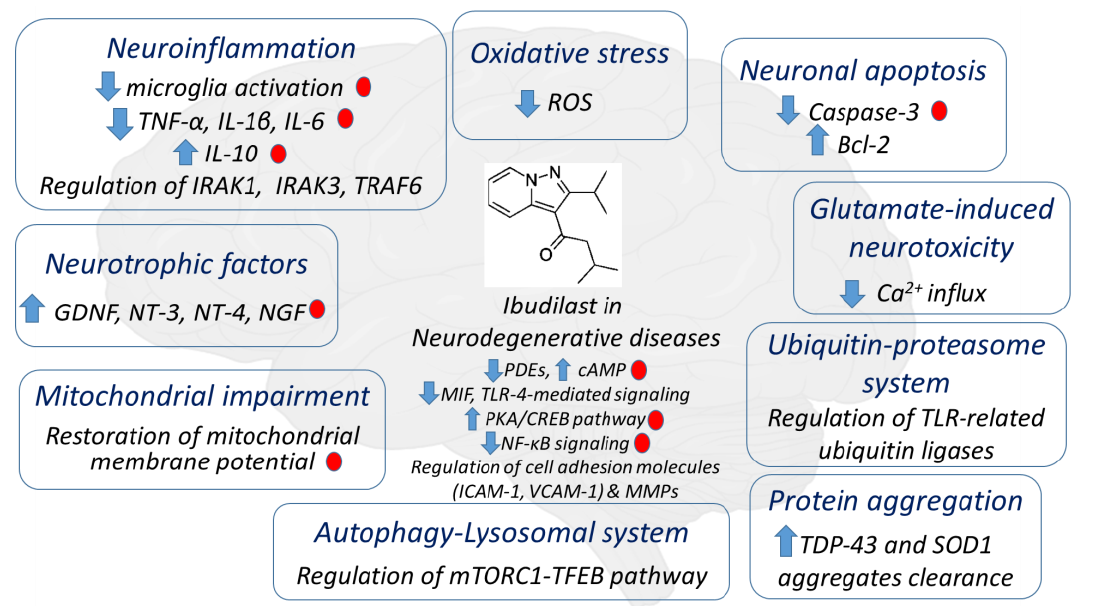
Figure 1. Effects of ibudilast possibly related to neurodegenerative diseases. Ibudilast can suppress neuroinflammation by inhibiting microglia activation, downregulating the pro-inflammatory cytokines TNF- α , IL-1 β and IL-6, upregulating the anti-inflammatory cytokine IL-10 and regulating IRAK1, IRAK3 and TRAF6. Ibudilast can upregulate the neurotrophic factors GDNF, NT-3, NT-4 and NGF and prevent mitochondrial impairment by restoring the mitochondrial membrane potential. It can also affect the autophagy-lysosomal system by regulating mTORC1-TFEB pathway. Ibudilast can also promote TDP-43 and SOD1 aggregates clearance, thereby suppressing abnormal protein aggregation. Ibudilast also affects ubiquitin–proteasome system by regulating TLR-related ubiquitin ligase, and it protects against glutamate-induced neurotoxicity by reducing Ca 2+ influx. Ibudilast also protects against neuronal apoptosis by downregulating caspase-3 and upregulating bcl-2. Ibudilast may also suppress oxidative stress by reducing the production of ROS. Apart from PDEs inhibition, ibudilast can also inhibit MIF and TLR-4. MIF inhibition and subsequent MIF reduction results in the downregulation of its receptor CD74 and AKT expression. TLR-4 blocking may lead to the reduced production of pro-inflammatory cytokines via pathways that also implicate NF- κ B, IRAK1 and TRAF6. Although it is not fully elucidated which of the above molecular and cellular effects of ibudilast are mediated through PDE inhibition; the small red circles indicate the specific mechanisms that there is some evidence suggesting to be at least partially induced by the inhibition of